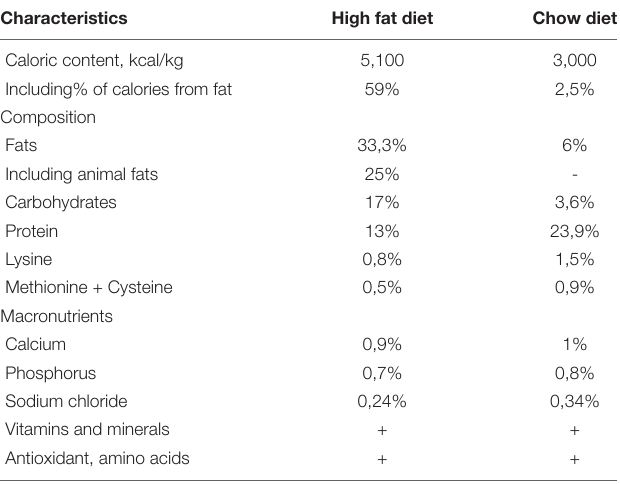
TABLE 1 | Characteristics of diets for the experimental (High fat diet) and control groups (Chow diet).